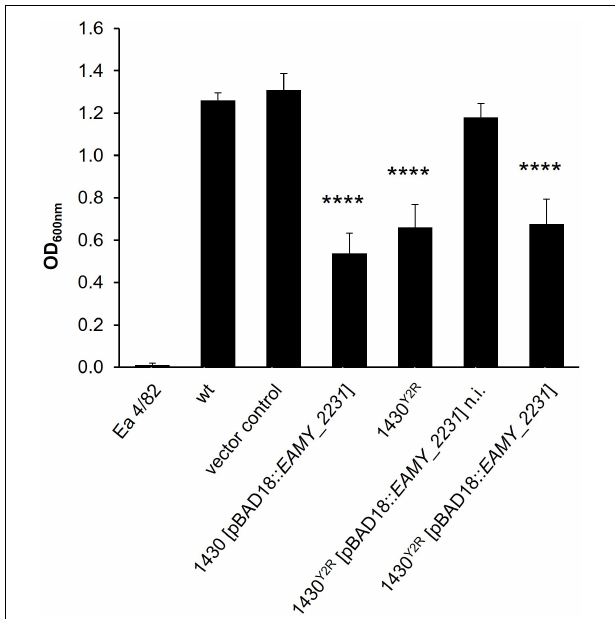
FIGURE 6 | Amylovoran-CPC precipitation. Quantitative amylovoran measurements were carried out for the generated mutants. Produced amylovoran was precipitated with CPC and measured by optical density (OD 600 nm ). The EPS lacking strain Ea4/82 was used as negative control alongside wild type CFBP1430 (wt) and CFBP1430 carrying the empty vector (vector control) as positive controls. Error bars indicate standard deviation. Statistical analysis was done by an ordinary one way ANOVA comparing samples to the wild type p < 0.0001. Each sample was tested at least three times independently. n.i., not